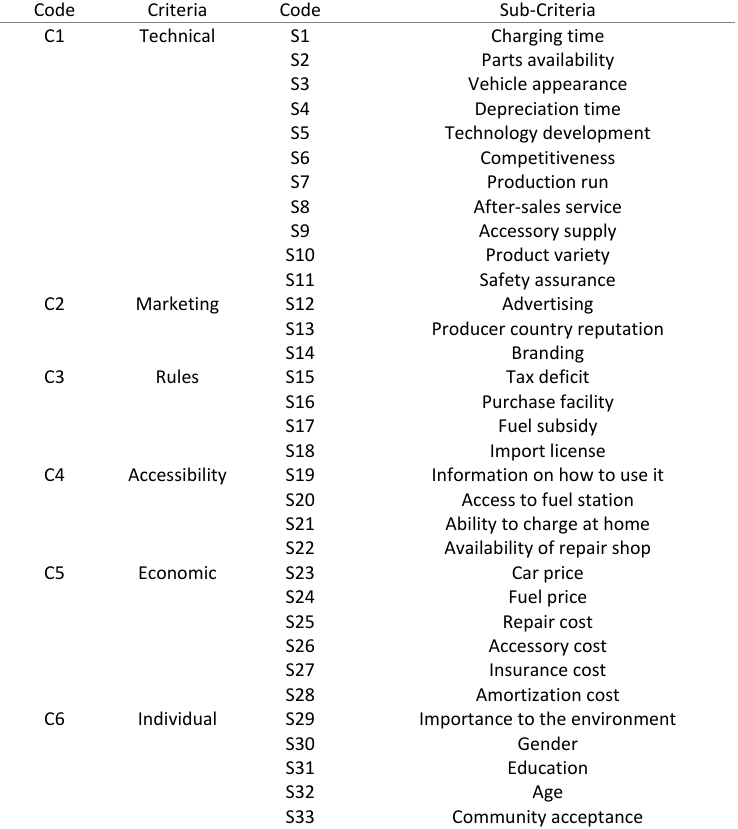
Table 2: EVs adoption effective factors coding